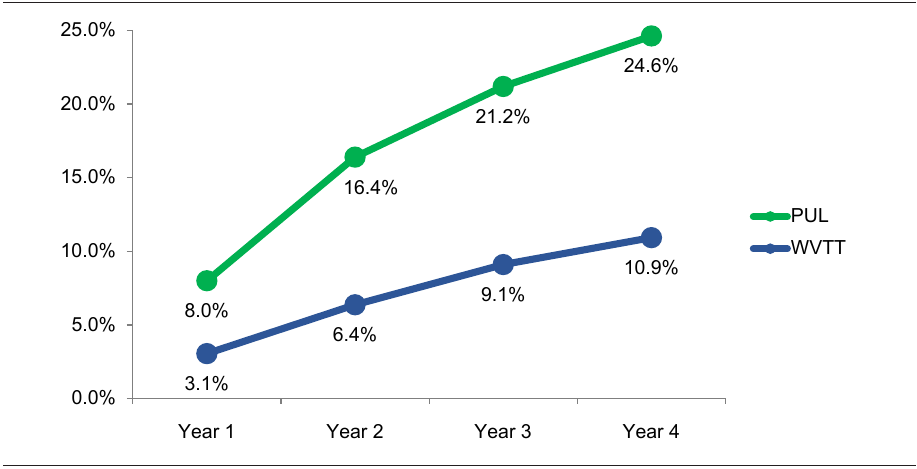
Figure 2. Annual Retreatment Rates of PUL and WVTT from Years 1 to 4